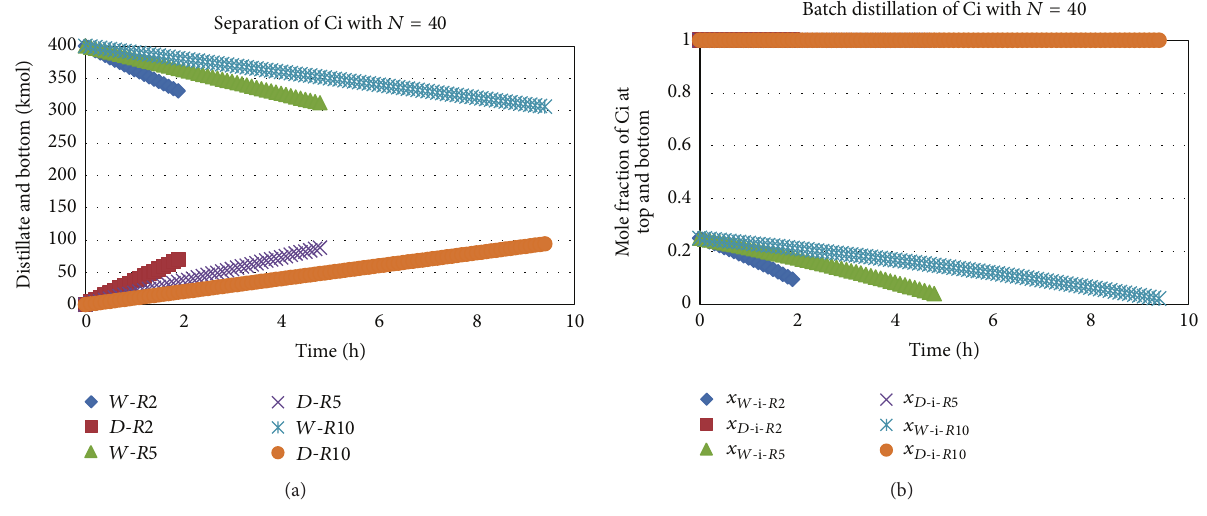
Figure 4: Results for four components batch distillation at reflux ratios of 2, 5, and 10 for a column with 40 theoretical